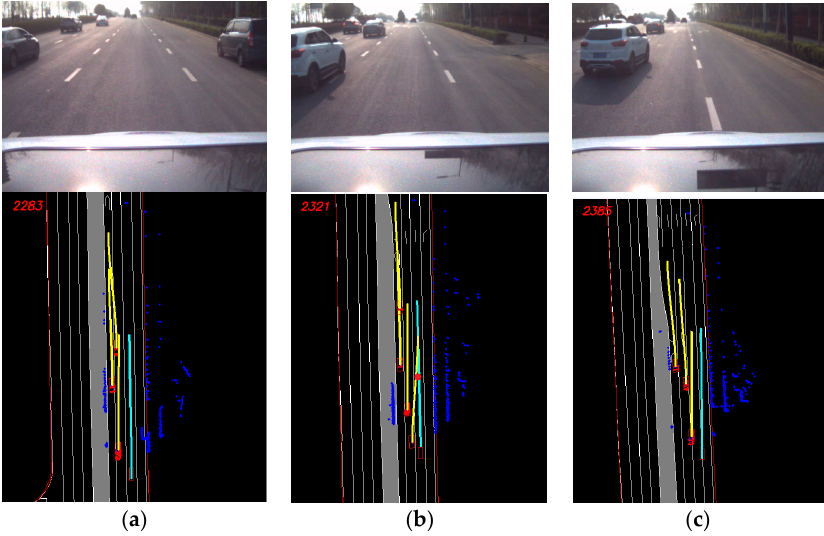
Figure 17. Collision avoidance on a straight road. ( a ) Keep lane without collision point detected; ( b ) collision point is detected and represented with a red point; ( c ) a lane change path is generated to avoid the potential collision. Trajectories of detected vehicles are represented by yellow lines and the planned path of the autonomous vehicle is represented by a green line. The red numbers represent the sequence number of the processed data from sensors and the internal between two frames is 40 ms.